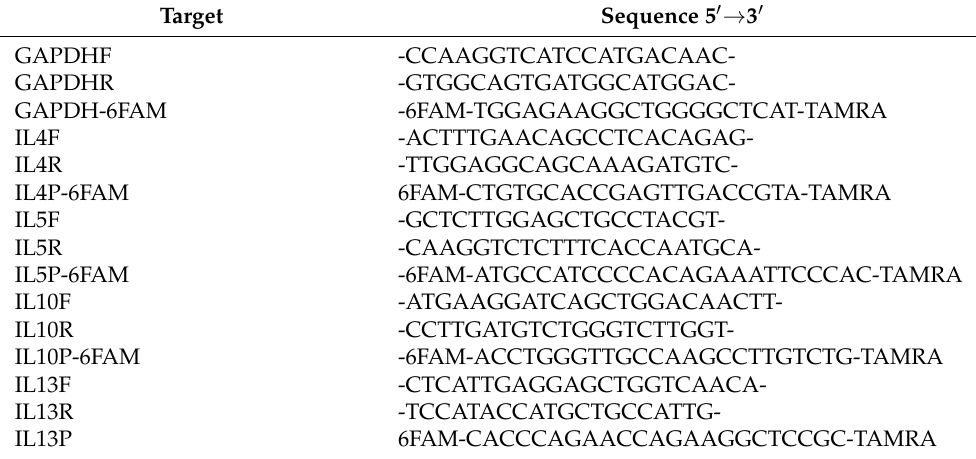
Table 1. Primer and